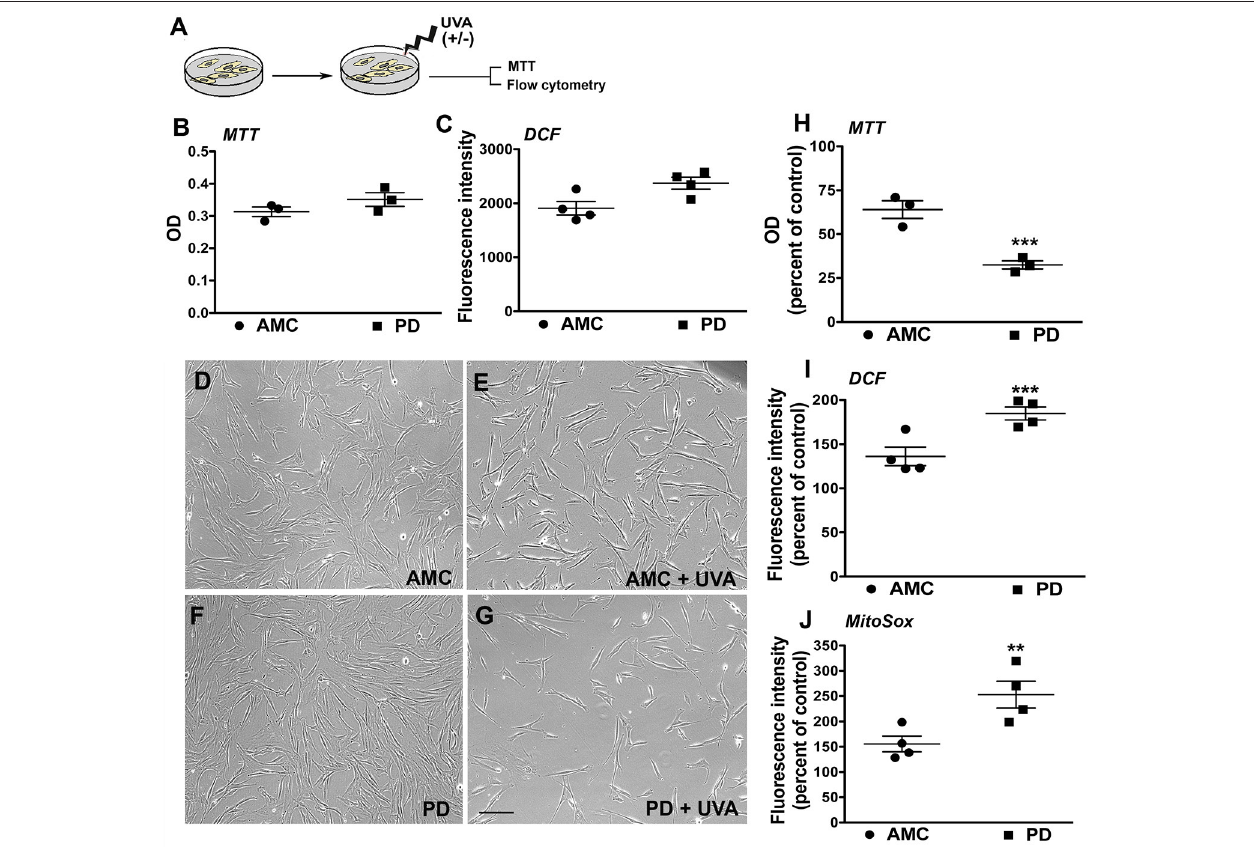
FIGURE 3 | Reduced viability and increased oxidative stress in PD cultures after UVA. (A) Schematic of the experimental design. Baseline MTT and DCF analysis is depicted in (B,C) . Phase contrast images of PD and AMC cells before and after UVA treatment is shown in (D–G) . Comparative viability of PD and AMC cells after UVA via an MTT assay is depicted in (H) . Quantification of DCF-DA (I) and Mitosox (J) fluorescence post-UVA, shows greater ROS production in PD lines Scale Bars: (B–E) = 200 µ m. * p < 0.05, ** p < 0.01, *** p < 001, (B,C) unpaired t -tests with Welch’s correction, (H–J) One way ANOVA with Bonferroni’s post-hoc test, Mean ± SEM, n = 3–4 independent PD and AMC